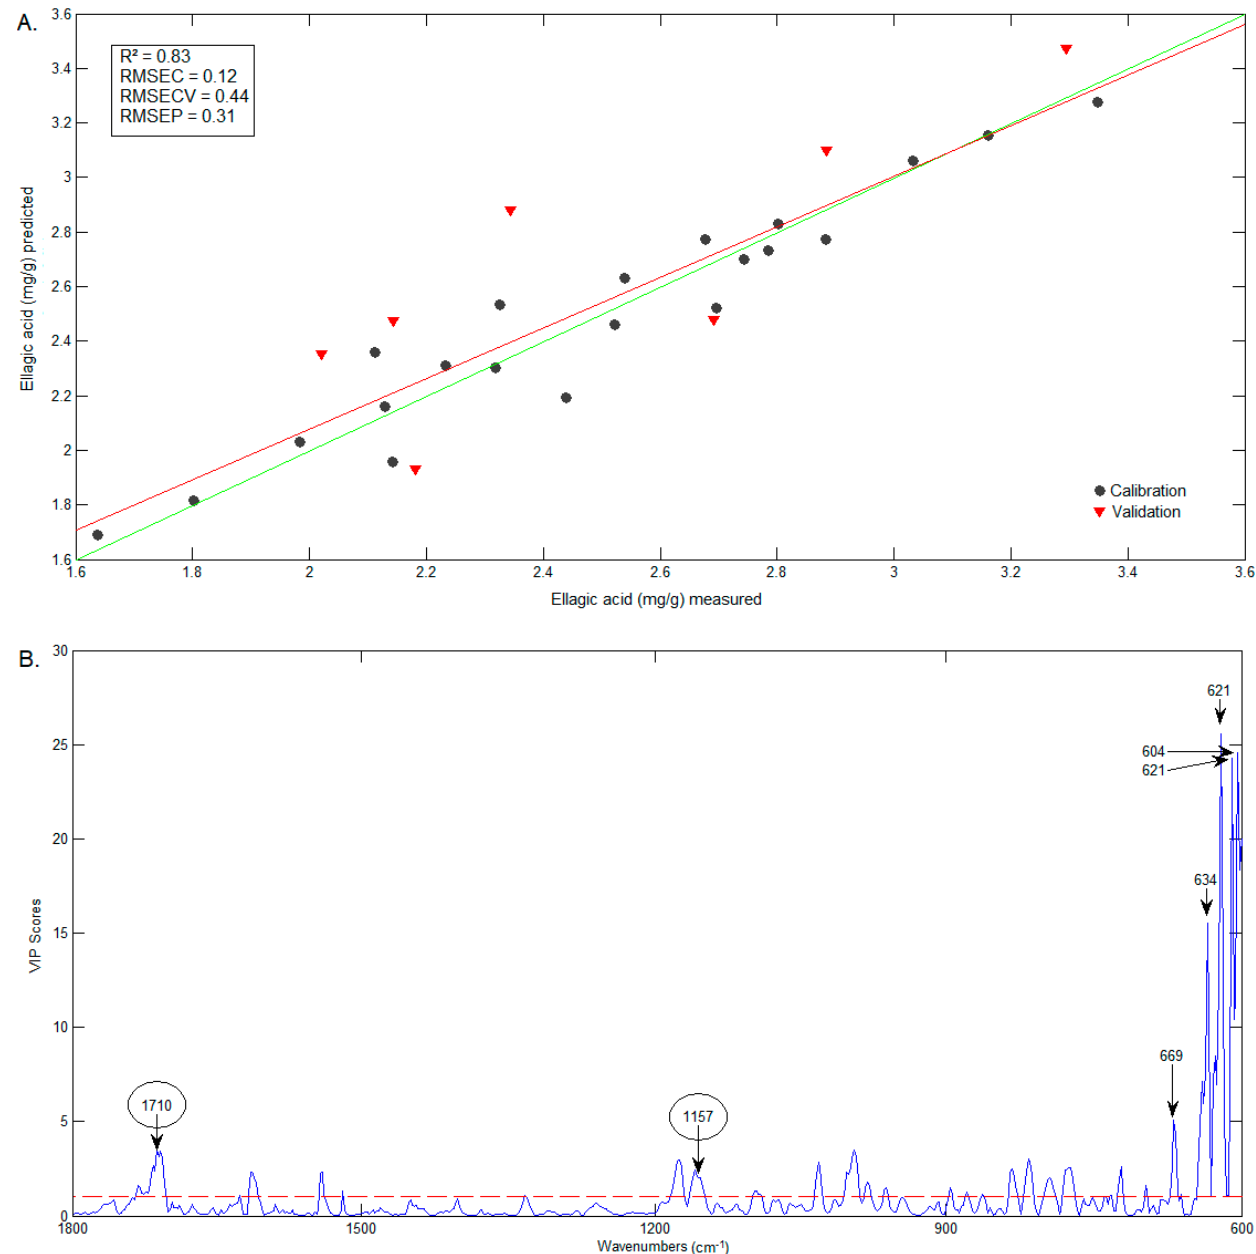
Figure 10. Graphics of the predicted vs. measured values ( A ) and of the VIP scores ( B ) of ellagic